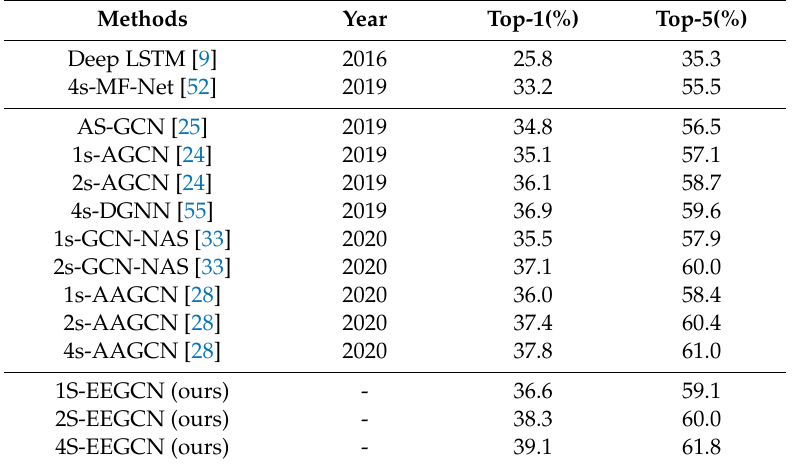
Table 8. The accuracy comparisons with state-of-the-art methods on the Kinetics-Skeleton dataset.